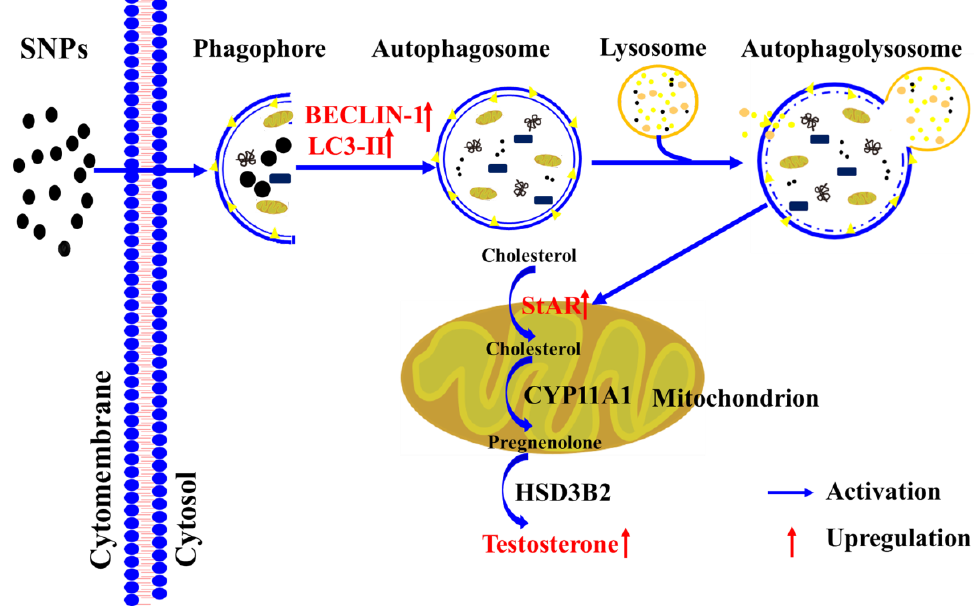
Figure 8. Schematic diagram of the signaling pathway involved in SNP-induced testosterone secretion in Leydig cells.